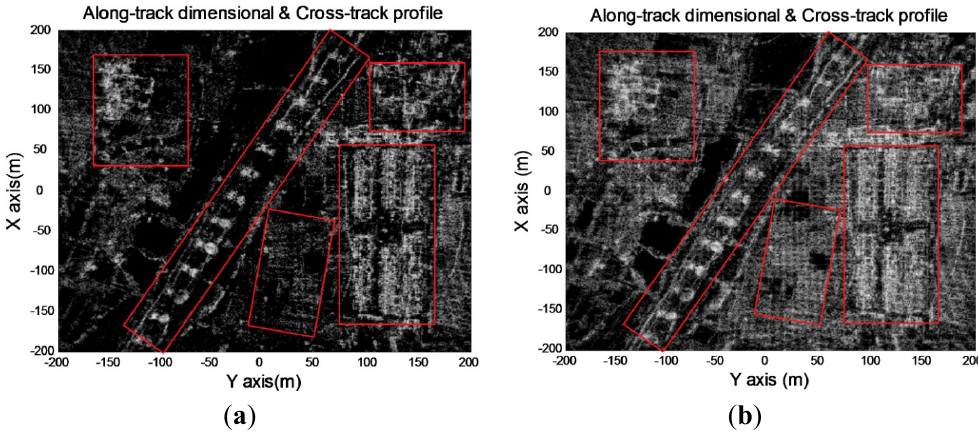
Figure 20. XY projection image: ( a ) XY projection image reconstructed with